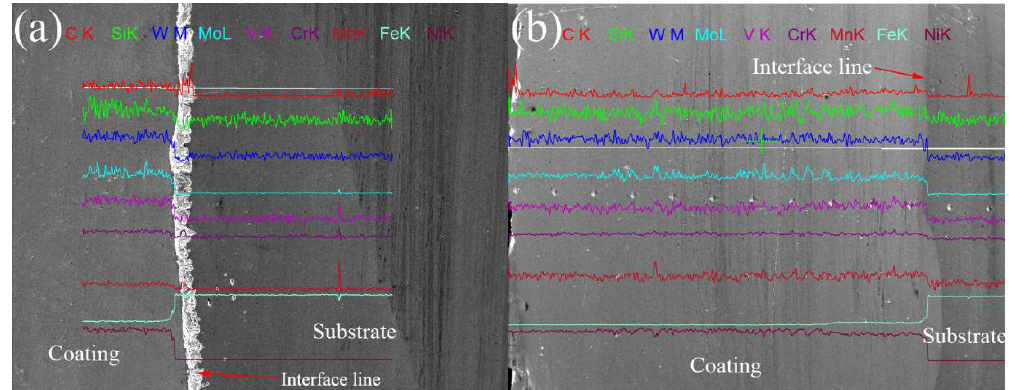
Figure 6. X-ray energy dispersive spectroscopy line scan across the interface region of the monolayer region ( a ) and trilayer coatings ( b ).